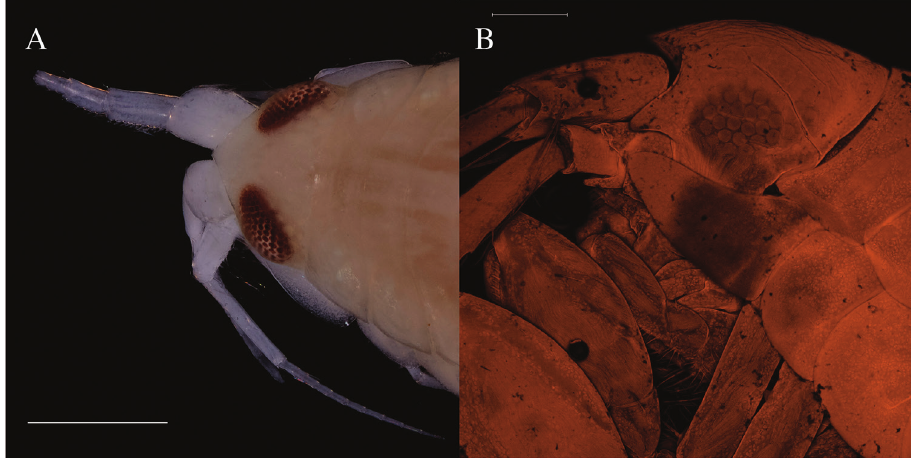
Figure 7. Eyes of, A Rhachotropis helleri AMPIV233-17, ommatidiae (Photo) B Rhachotropis oculata AMPIV228-17 (CLSM), 7 stack-layers have been removed in the eye-region to reveal the ommatidia beneath the